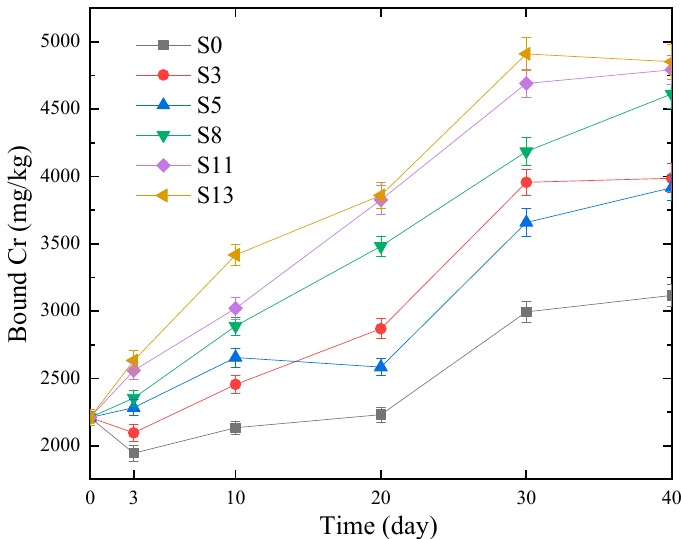
Figure 3. Concentrations of the bound fraction during remediation.